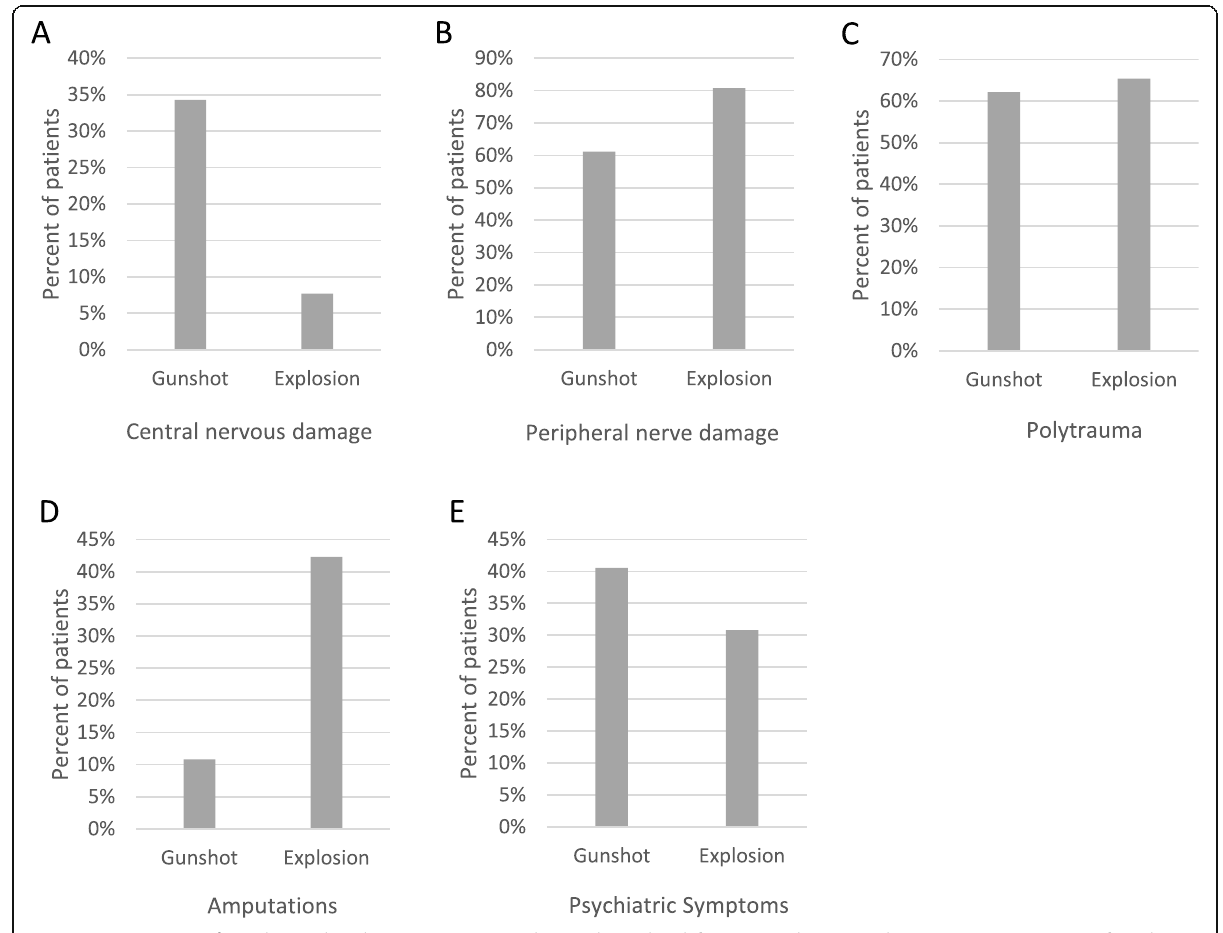
Fig. 4 Injury patterns of gunshot and explosion injuries. Central ( a ) and peripheral ( b ) nervous damage, polytrauma ( c ), amputations ( d ) and psychiatric symptoms ( e